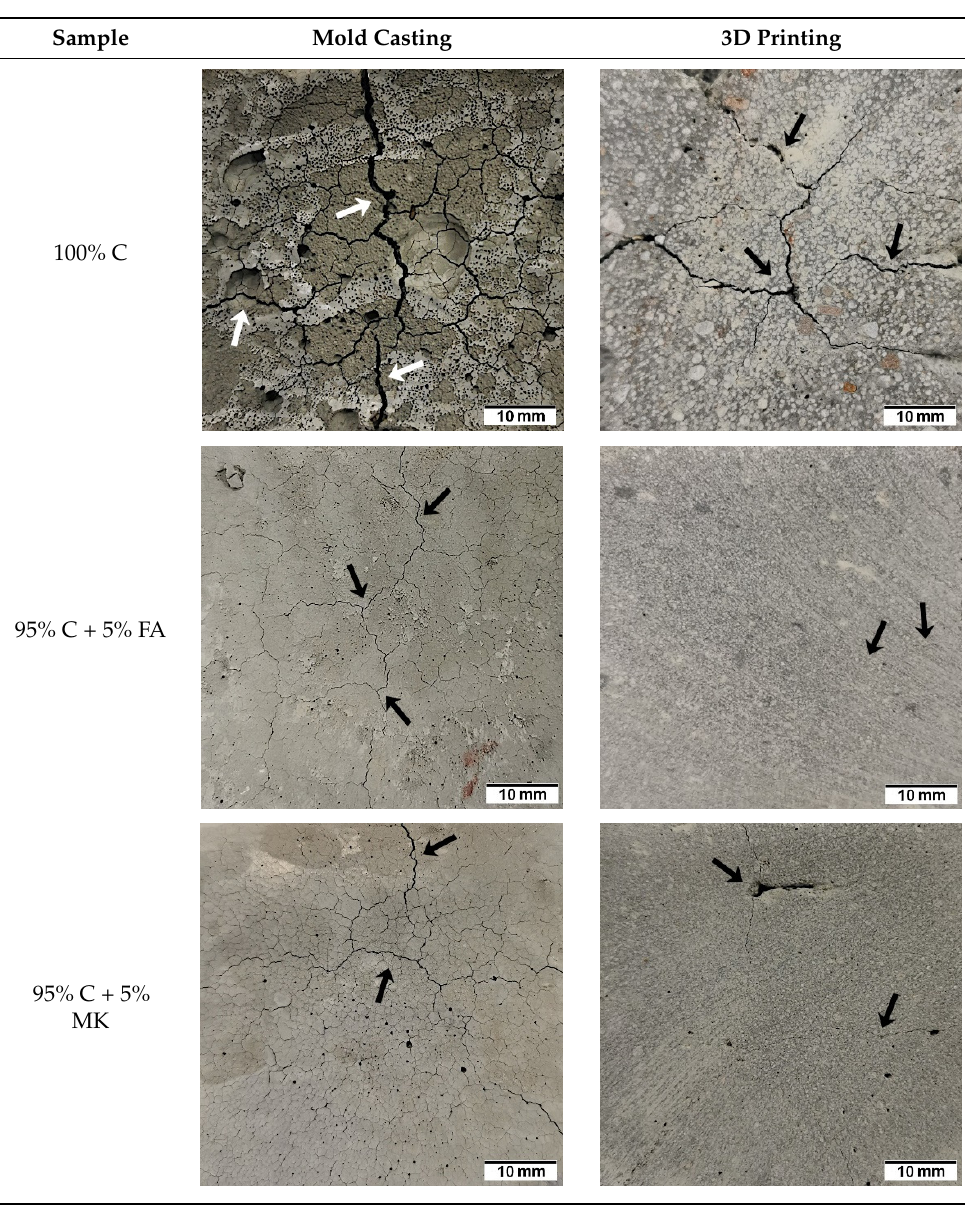
Figure 6. The mass loss after fire-resistance tests for concrete (100% C) and concrete-geopolymer hybrids based on fly ash (95% C + 5% FA) and metakaolin (95% C + 5% MK) that were cast and 3D printed.